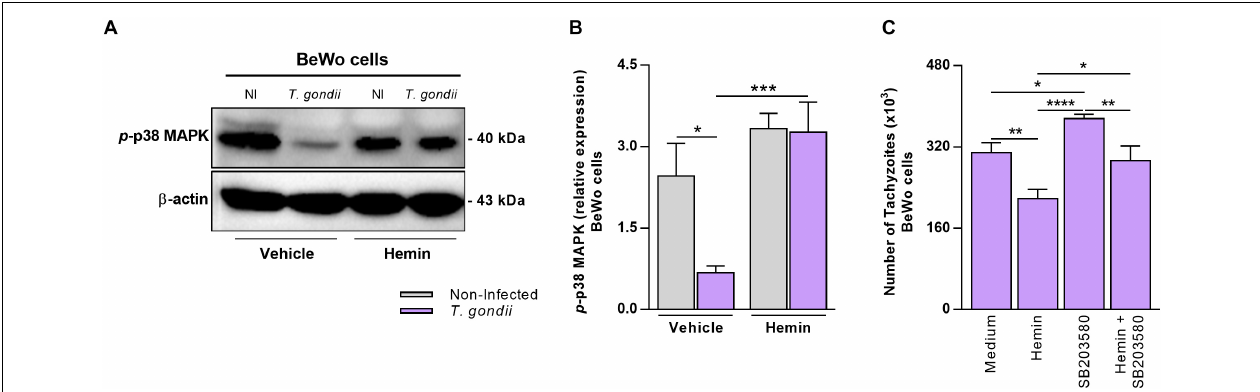
FIGURE 4 | Influence of HO-1 induction on p38 MAPK activation in BeWo cells under T. gondii infection. (A,B) BeWo (1 × 10 6 cells/2,000 µ l/well) cells were cultured in six-well plate during 24 h, infected with T. gondii (1:1) or not (control) for 3 h, treated with hemin (80 µ M) or not (NaOH at 0.08% as vehicle) during 24 h, and submitted to western blotting assays for detection of phosphorylated p38 MAPK and β -actin. Protein bands were photodocumented, and densitometric analysis was performed by the ratio among phosphorylated p38 MAPK ( p -p38 MAPK) and its corresponding β -actin (endogenous control). (A) Representative blots for p -p38 MAPK and β -actin in the non-infected (NI) or infected ( T. gondii ) and hemin-treated or not (vehicle) BeWo cells. (B) Densitometric analysis for p -p38 MAPK. (C) BeWo (3 × 10 4 cells/200 µ l/well) cells were cultured in 96-well plate during 24 h, pretreated with 10 µ M of SB203580 (p38 MAPK inhibitor) or not (control) for 3 h, infected with T. gondii (1:1) for 3 h, and treated with hemin (80 µ M) or not (control) during 24 h, and the T. gondii intracellular proliferation was analyzed by the β -galactosidase assay. The data were shown as number of tachyzoites ( × 10 3 ). For both assays, the results were expressed as mean ± SEM from two or three independent experiments performed in six or eight replicates. Significant differences were statistically assessed by the Mann-Whitney test (B) or by one-way ANOVA with Bonferroni’s posttest (C) ; * P < 0.05; ** P < 0.01; *** P < 0.001; **** P <